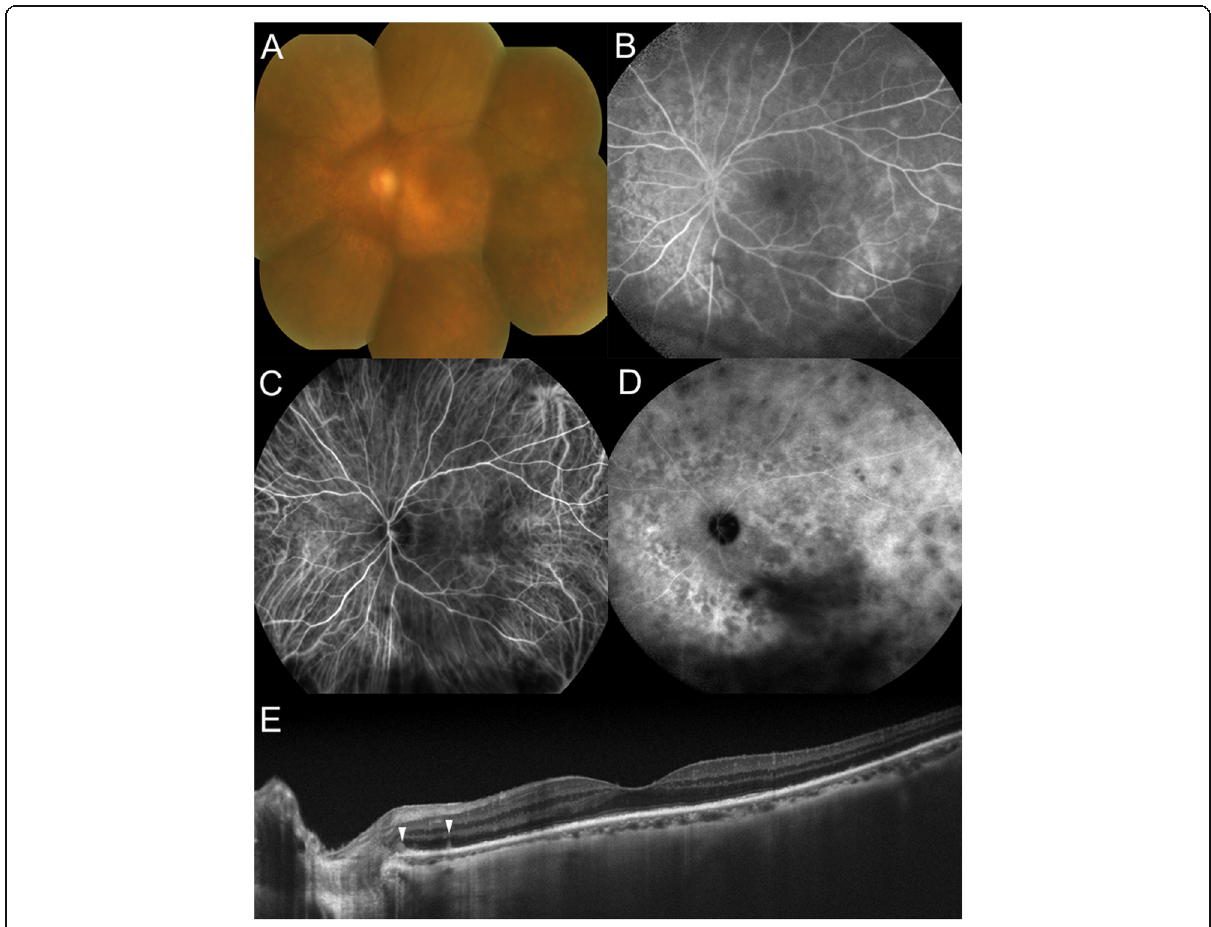
Fig. 1 Findings of the left eye at the initial visit in a 70-year-old woman with multiple evanescent white dot syndrome with panuveitis. a Fundus was seen hazy due to diffuse vitreous opacity. Multiple subretinal white dots at the mid-periphery could be barely observed. b Corresponding to the white dots, fluorescein angiography (FA) 2 min. after the dye injection showed hyperfluorescence as well as at the peripapillary area. c, d Indocyanine green angiography (ICGA) showed no abnormal findings 1 min. after the dye injection ( c ) and numerous hypofluorescent dots extending from the peripapillary area and posterior pole to the mid-periphery 16.5 min. after the dye injection ( d ). Inferior black shadow resulted from the vitreous opacity. e A horizontal image through the fovea on enhanced depth imaging optical coherence tomography (EDI-OCT) showed diffuse loss of the ellipsoid zone at the macula and hyper-reflective foci at the level of the photoreceptor